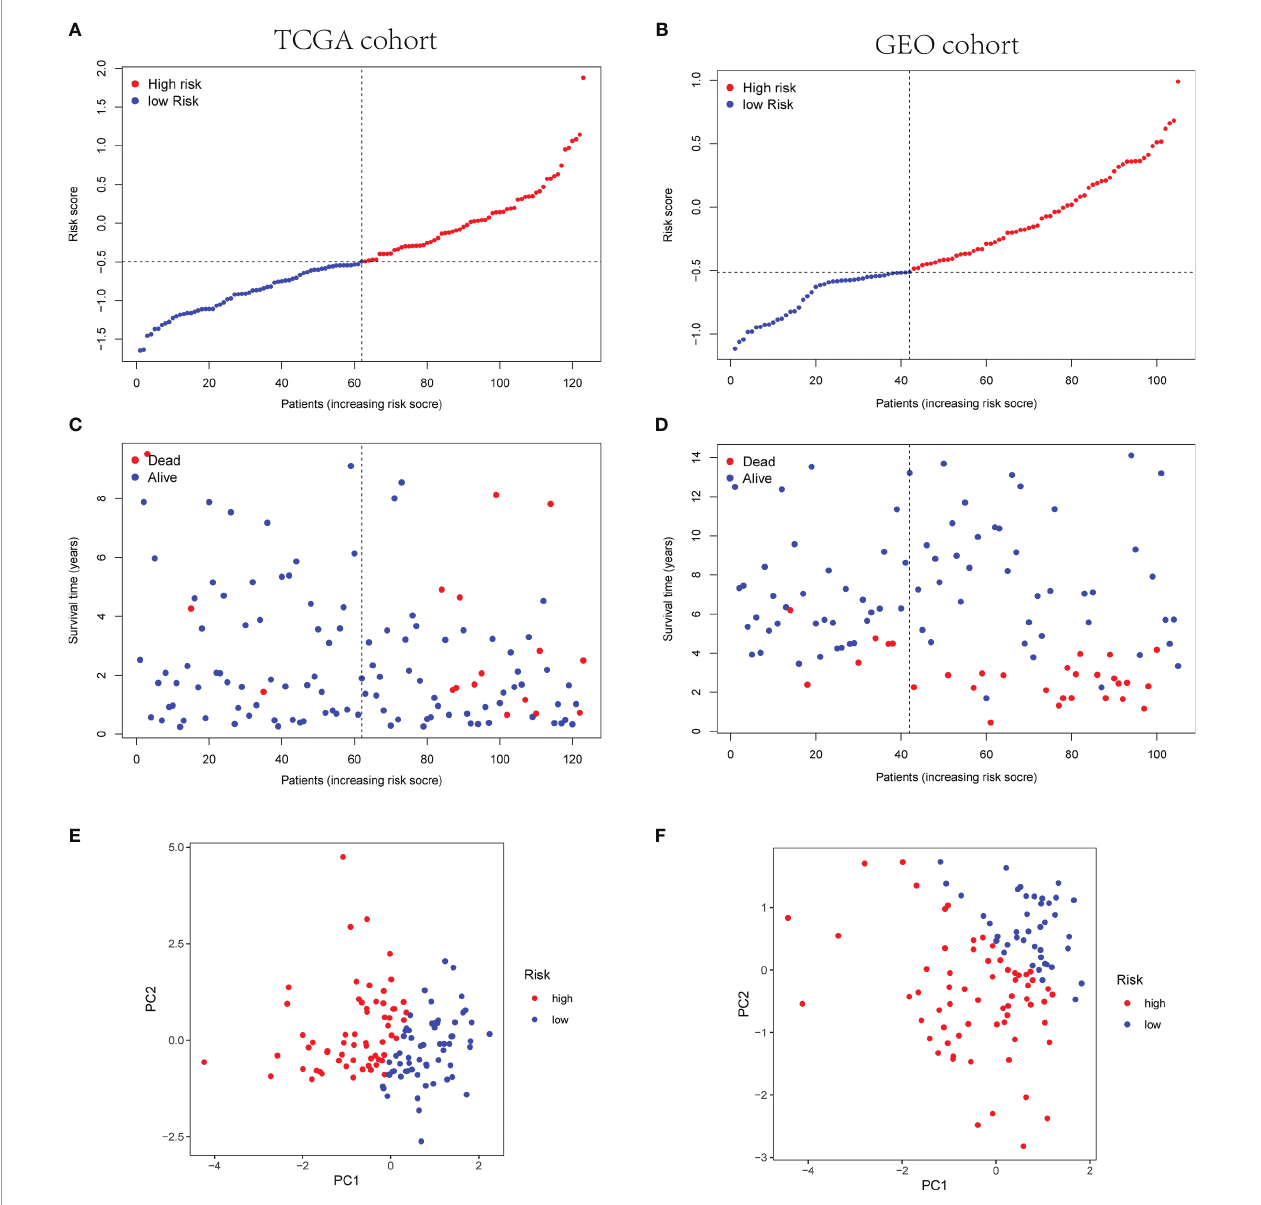
FIGURE 5 | Prognostic analysis of the three-gene signature model in TCGA cohort and GEO cohort. (A, B) The distribution and median value of the risk scores in TCGA cohort (A) and the median risk score of TCGA was set as the cutoff value of high- and low-risk groups in GEO cohort (B) . (C, D) The distributions of OS status and risk scores in TCGA cohort (C) and GEO cohort (D) . (E, F) PCA analysis plot of TCGA cohort (E) and GEO cohort (F)